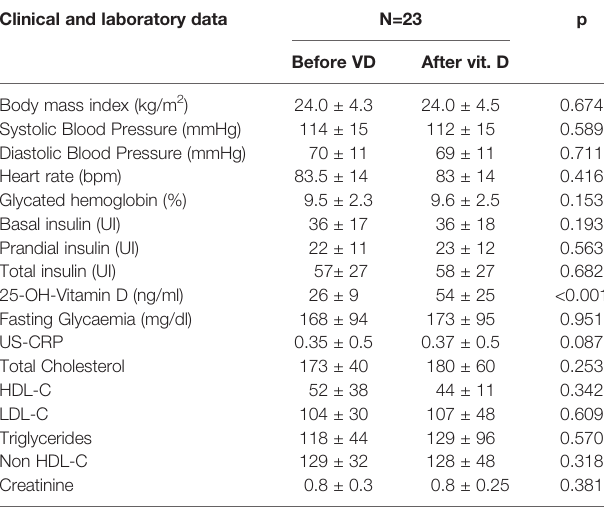
TABLE 2 | Clinical and laboratory data of enrolled T1DM patients with CAN, before and after VD supplementation. Clinical and laboratory data